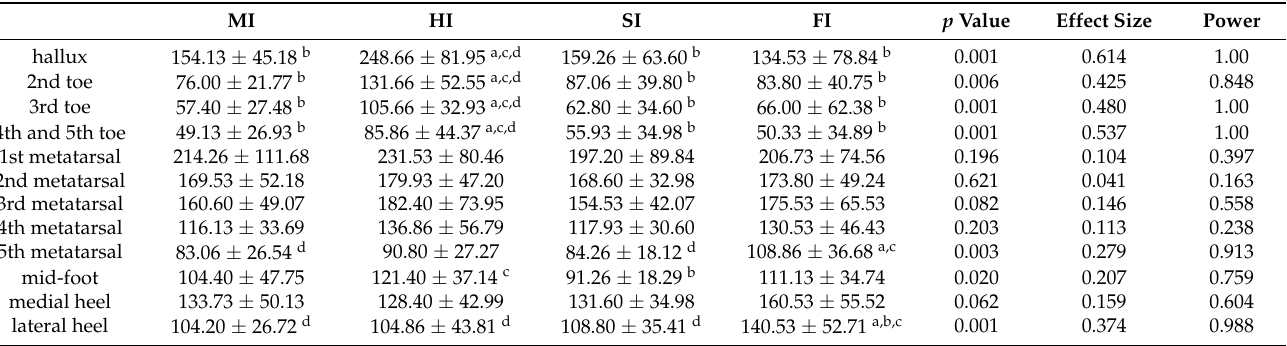
Table 3. Peak plantar pressure (KPa).